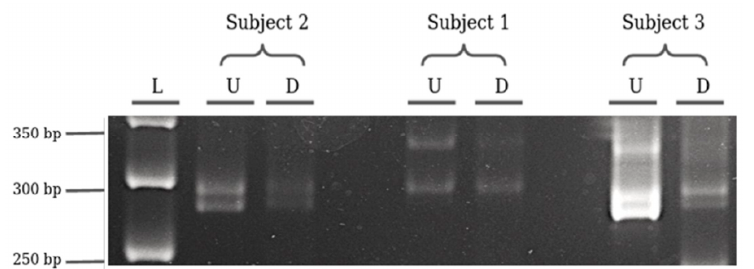
Figure 3. HUMARA test results. L: 50 bp Biolabs molecular marker; U: undigested subjects, D: digested subjects. Subject 2 amplicons length: allele 1 (26 repeats) 291 bp, allele 2 (22 repeats) 282 bp; subject 1 amplicons length: allele 1 (26 repeats) 291 bp, allele 2 (34 repeats) 324 bp; subject 3 amplicons length: allele 1 (26 repeats) 291 bp, allele 2 : (23 repeats) 286bp.